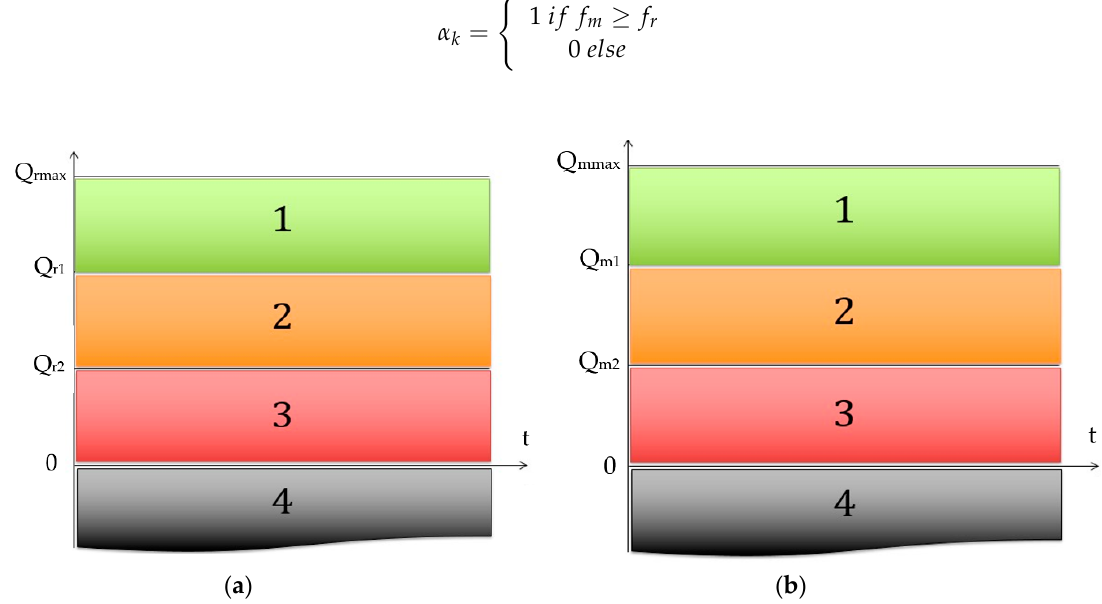
Figure 3. Dashboard functions. ( a ) Remanufacturing Unit; ( b ) Manufacturing Unit.